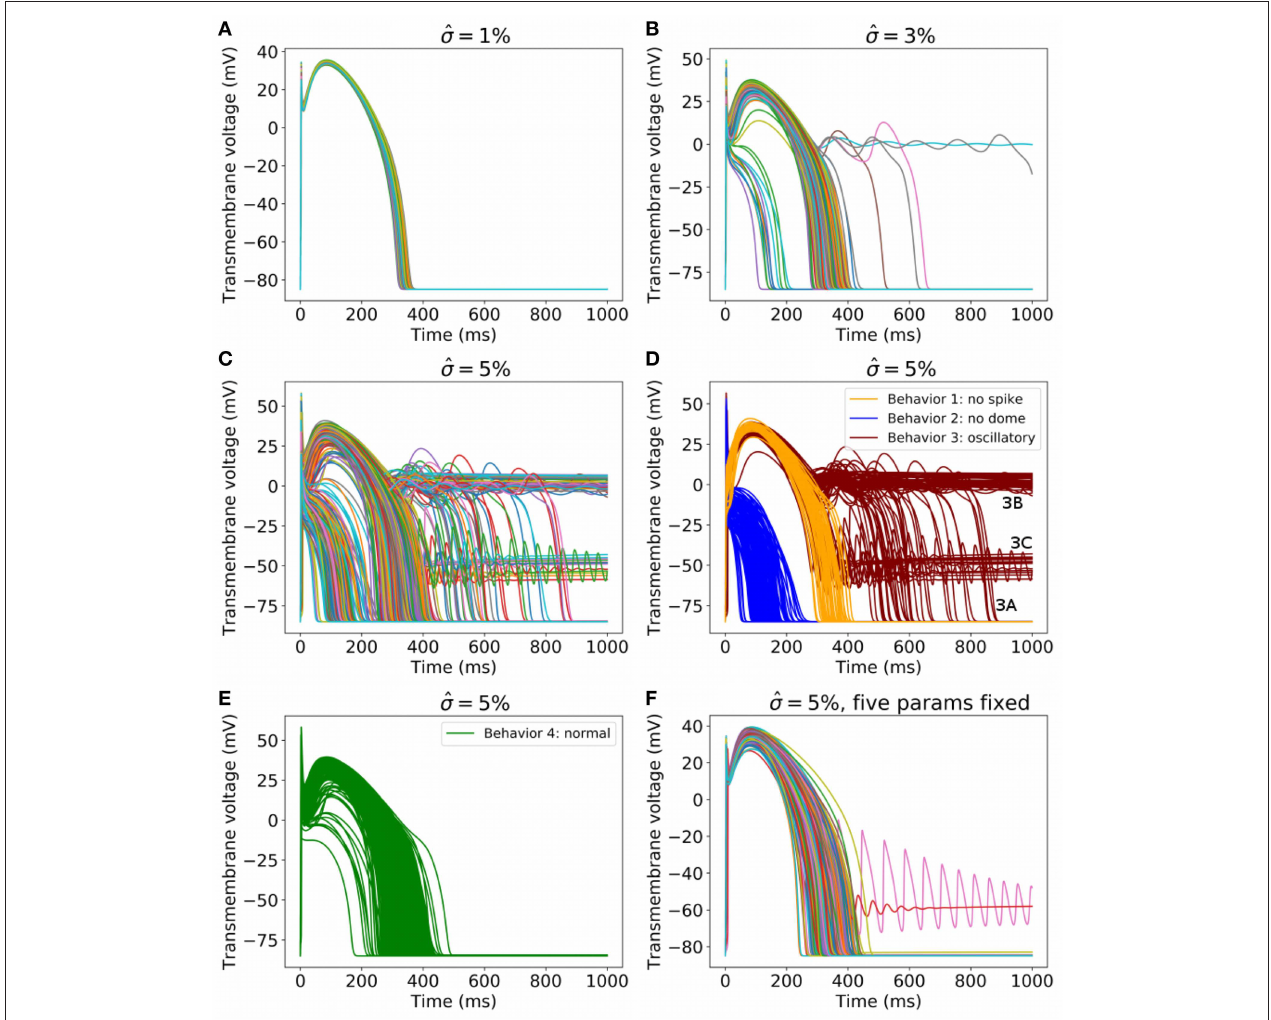
FIGURE 6 | (A–C) 1,000 randomly sampled action potentials with: (A) ˆ σ = 1 % (small amount of uncertainty in all cell model parameters); (B) 3 % (medium uncertainty); (C) 5 % (larger uncertainty in all cell model parameters). (D) Action potentials for ˆ σ = 5 % , for three classes of behavior, colored by class (blue: spike but no dome; orange: dome but no spike; red: oscillatory). (E) All other action potentials for ˆ σ = 5 % . (F) 1,000 randomly sampled action potentials with ˆ σ = 5 % for all parameters except E h , δ h , E z , E d , E f held